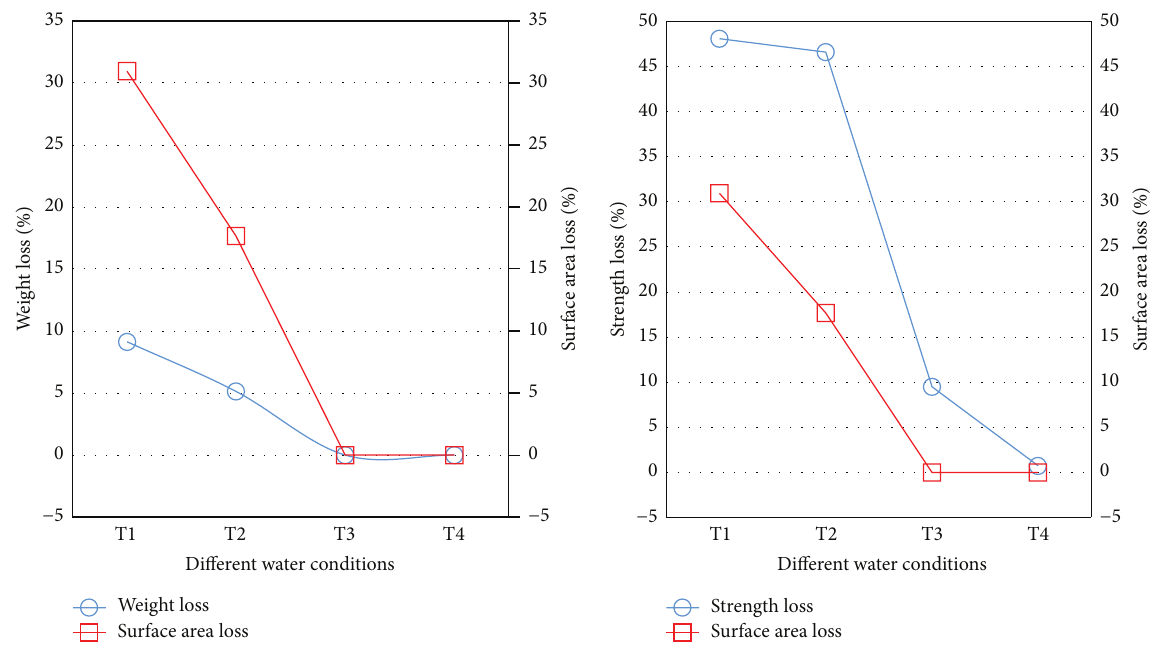
Figure 12: Comparison of surface area loss with weight loss and strength loss at 180